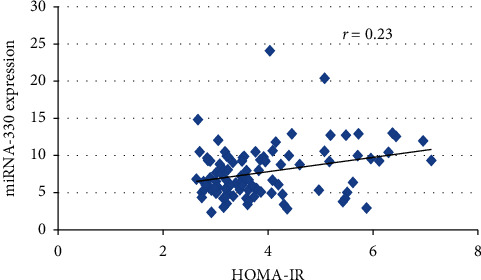
Correlation of HOMA-IR with microRNA-330 expression among T2DM cases.